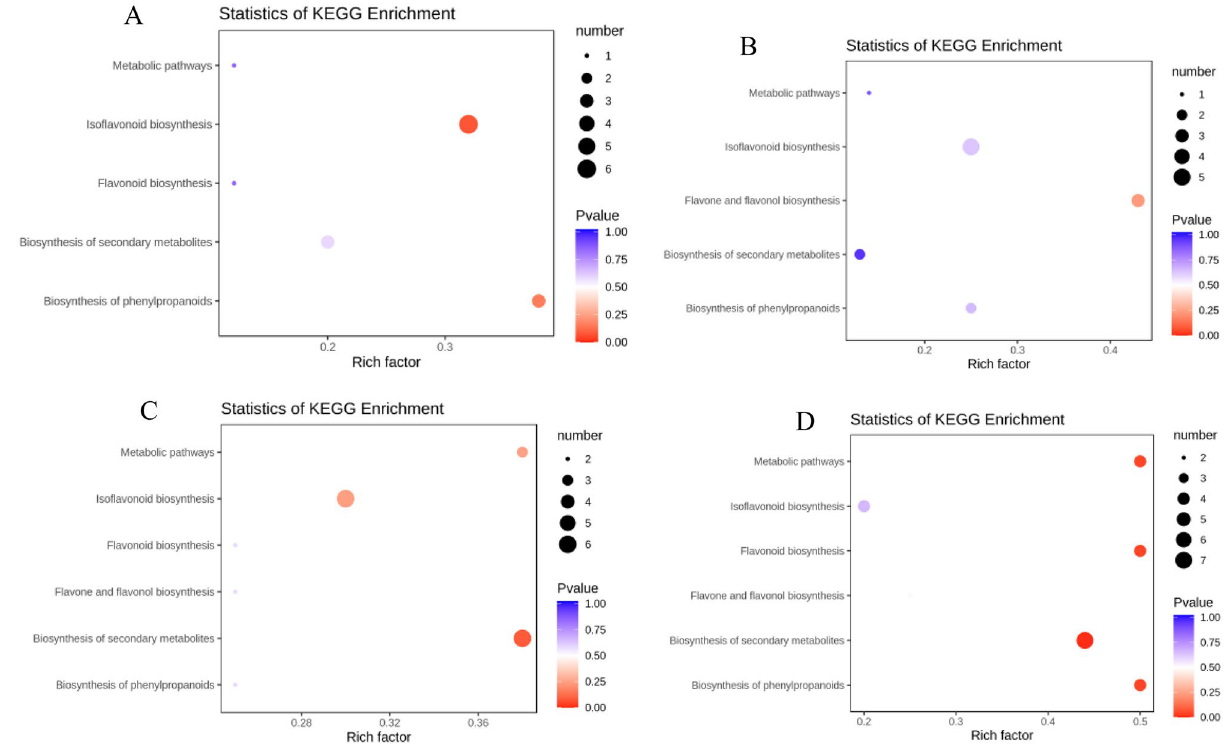
Figure 7. Differential metabolite KEGG enrichment map. ( A ): HN52 vs HN71; ( B ): HNS52 vs HNS71; ( C ): HN52 vs HNS52; ( D ): HN71 vs HNS71. Note: The abscissa represents the rich factor corresponding to each channel, the ordinate is the channel name, and the color of the point is p value. The more red, the more significant the enrichment. The size of the dot represents the number of different metabolites